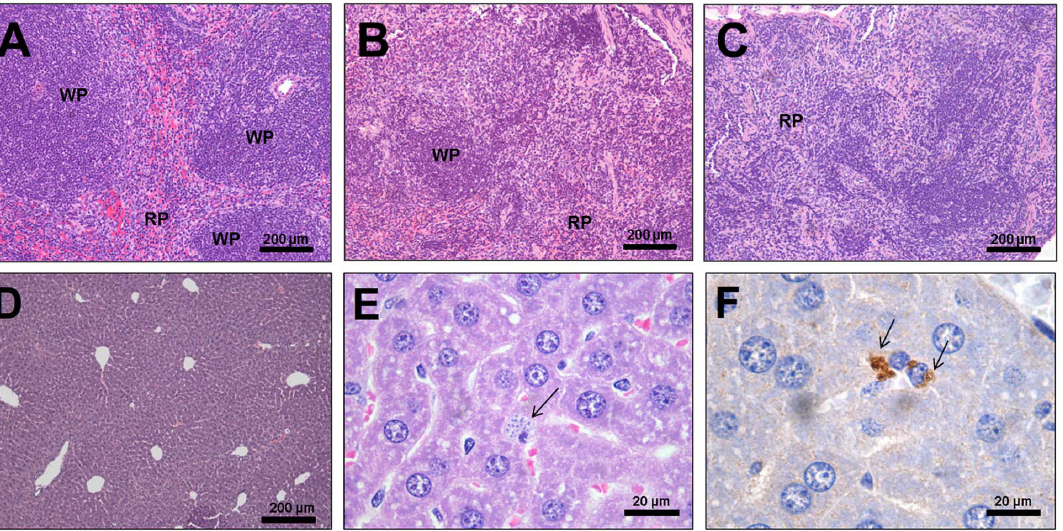
Fig. 4. Histopathological alterations in the spleen and liver. Representative images of a spleen with ( A ) organized white pulp, ( B ) moderately disorganized white pulp, and ( C ) highly disorganized white pulp. The decrease or absence of lymphoid follicles is evident in B and C. ( D ) Representative image of liver from CP mice. The presence of amastigotes (arrows) in the CPi liver detected with ( E ) hematoxylin and eosin stain and ( F ) immunohistochemistry. WP: white pulp; RP: red